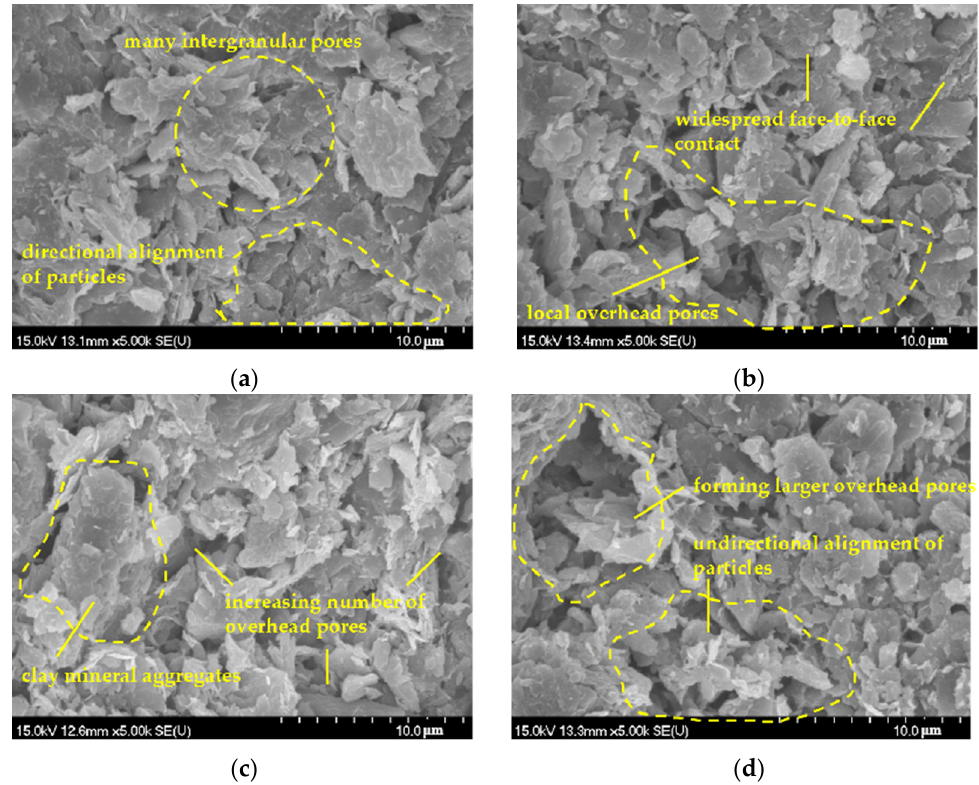
Figure 9. Microstructure of Zhoushan soil samples with different lime dosages. ( a ) Lime dosage: 0%, ( b ) lime dosage: 1%, ( c ) lime dosage: 2%, ( d ) lime dosage: 3%.